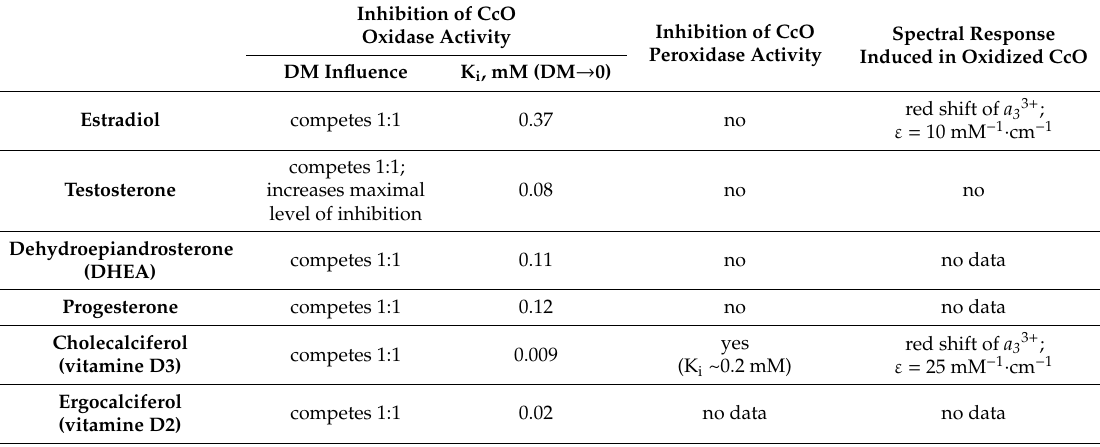
Table 1. Steroid regulatory molecules a ff ecting CcO.